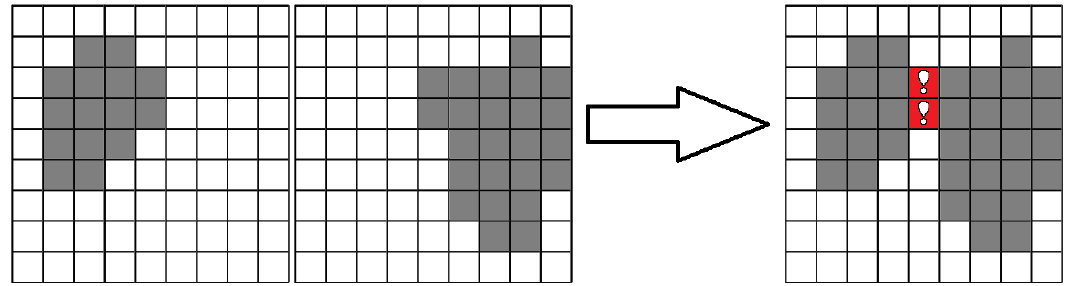
Figure 8. Searching the intersections in the voxel layers. Gray areas denote voxels of neighboring layers of the approximating model; red zones are the intersections of the voxel groups, which are used to construct the